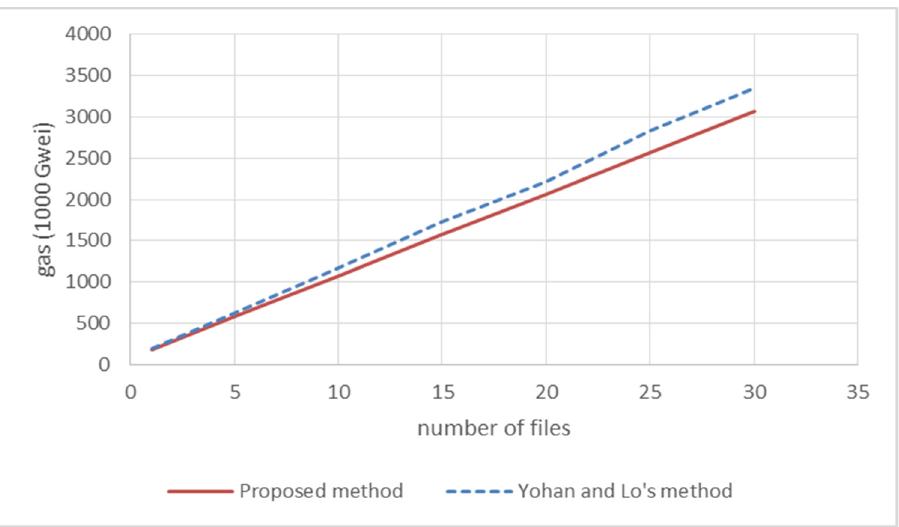
Figure 7. Comparison of the time cost in firmware uploading.